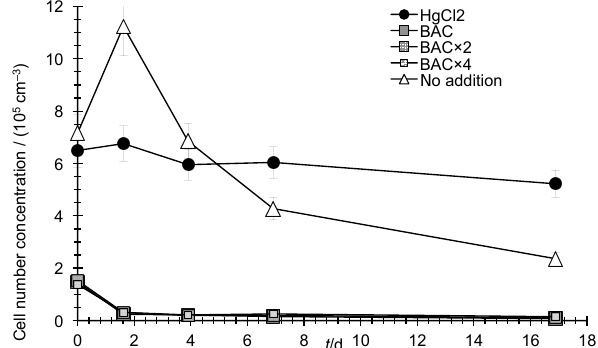
Figure 4. Number concentration of heterotrophic bacteria in sam- ples collected during TS3 treated with different concentrations of BAC, HgCl 2 and with no addition of